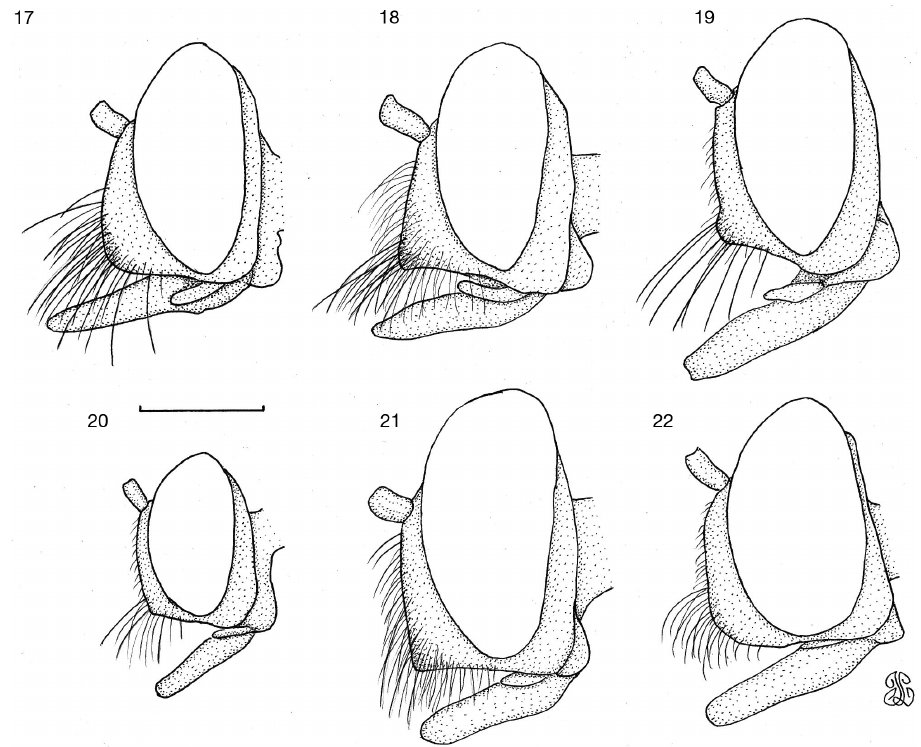
Figures 17–22. Illustrations of head profiles of Laphyctis species: 17 L. argenteofasciata (Ukasi ♂ ) 18 L. eremia sp. n. (Gobabeb ♂ ) 19 L. gigantella (Sawmills ♀ ) 20 L. iota (Kruger Park ♀ ) 21 L. orichalcea (Brandberg ♂ ) 22 Laphyctis sp. (Sawmills ♀ ). Scale = 1